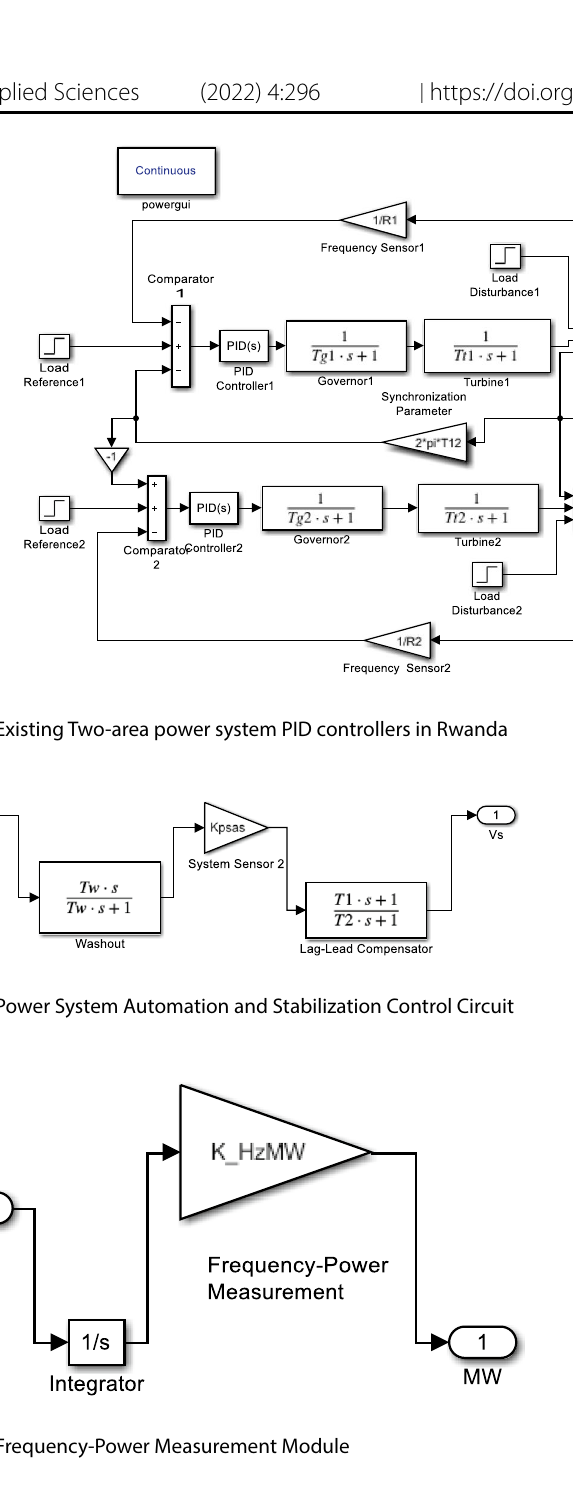
Fig. 7 Sudden R-L Load Applied to two interconnected